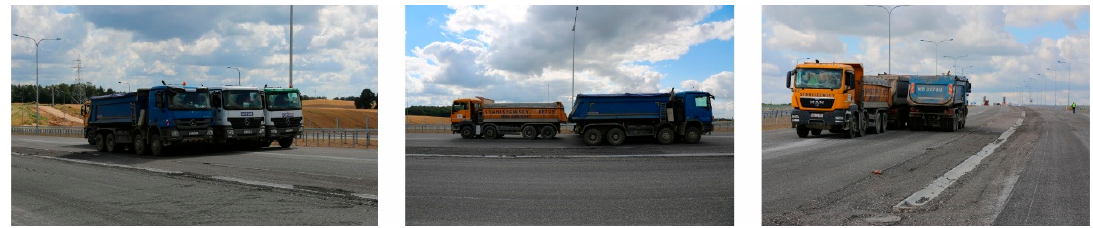
Figure 8. The trucks, positioned during the S1 test configuration. Views from three different perspectives.